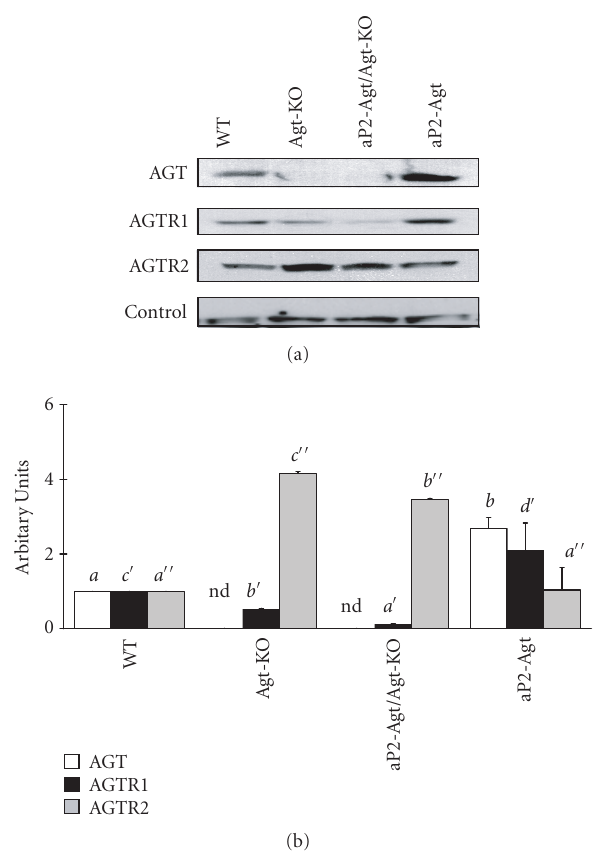
Figure 2: Expression of RAS proteins in the kidney of WT, Agt -KO, aP2- Agt / Agt -KO, and aP2- Agt mice. Representative immunoblots of AGT, AGTR1, and AGTR2 proteins are shown. A 75kD protein is included as an internal loading control. Bars depict mean ± SEM of the quantitated AGT, AGTR1, and AGTR2 protein bands, indepen- dently obtained from 3 di ff erent experiments. Values with di ff erent letters are significantly di ff erent ( P < . 05); nd: not